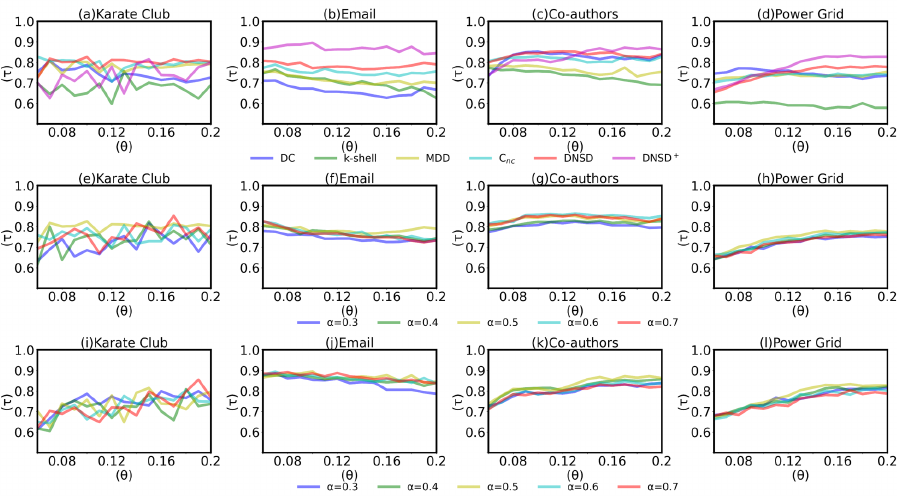
Figure 5. The Kendall’s τ between the rankings obtained by different methods and the spreading capacity simulated by the SIR model: α is set to 0.5 and β is set to 0 ( a – d ); the τ of DNSD with α set between 0.3 and 0.7 with an an interval of 0.1 ( e – h ); and the τ of DNSD + with α set between 0.3 and 0.7 with an an interval of 0.1 ( i – l ).